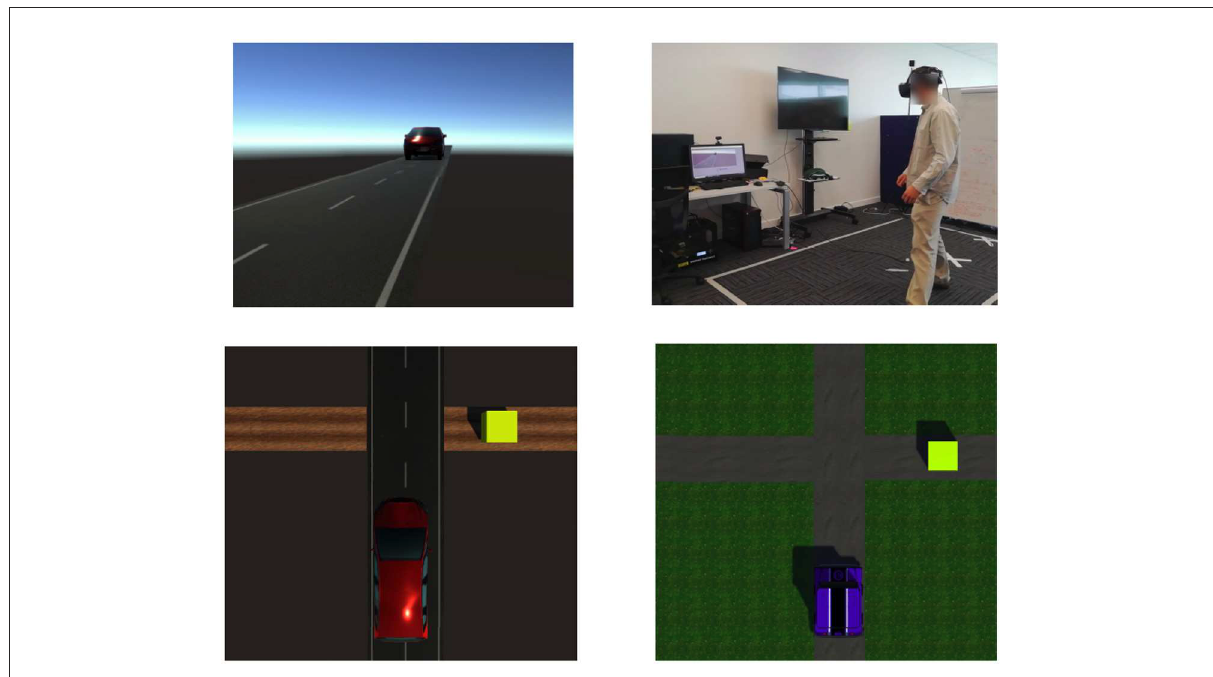
FIGURE7 Virtual reality experiment (Camara et al.,